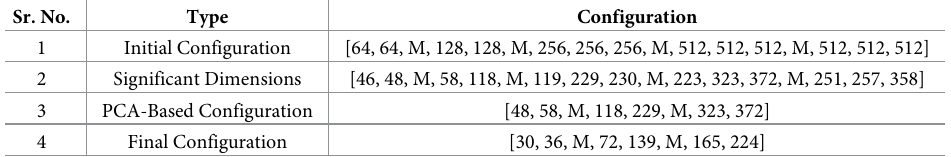
Table 3. Configuration of VGG-16 on CIFAR-10.